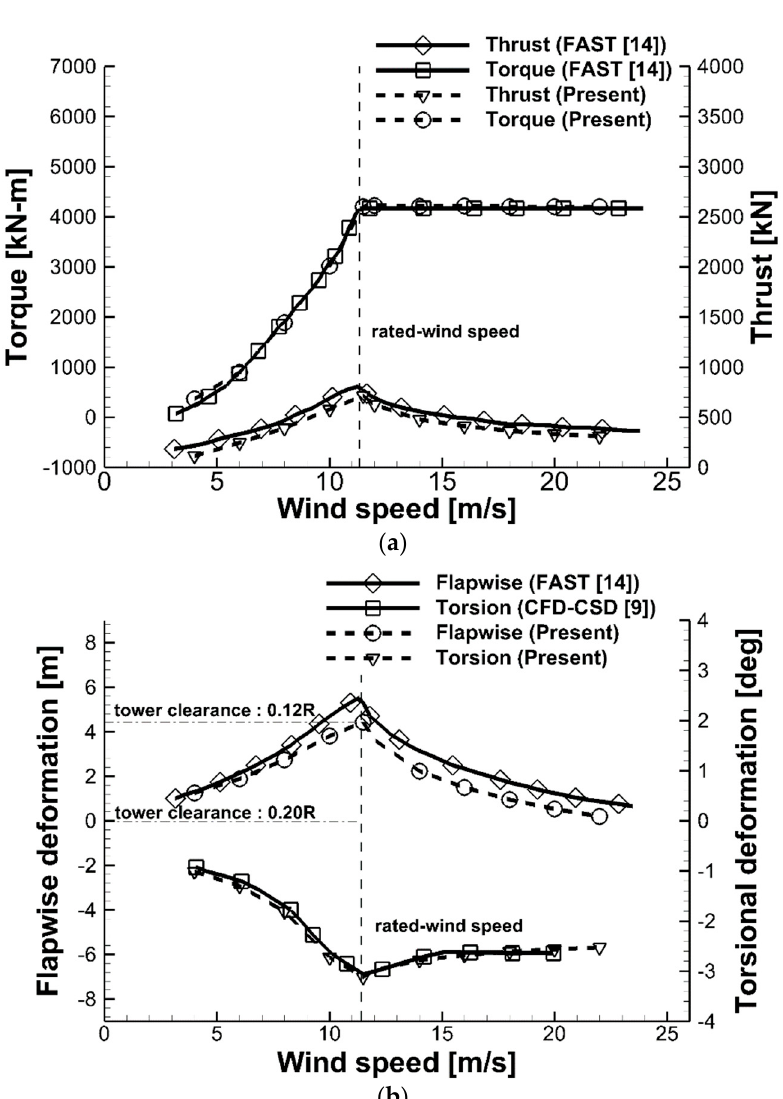
Figure 3. Rotor aerodynamic loads and blade tip deformations of bottom-fixed wind turbine with varying wind speed. ( a ) Rotor aerodynamic loads. ( b ) Blade tip deformations.